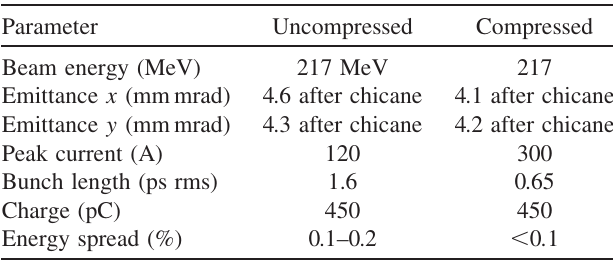
TABLE I. Summary of the beam parameters for uncompressed and compressed states in the previous COTR and SASE tests at 530 nm performed on December 20, 2001 [5].